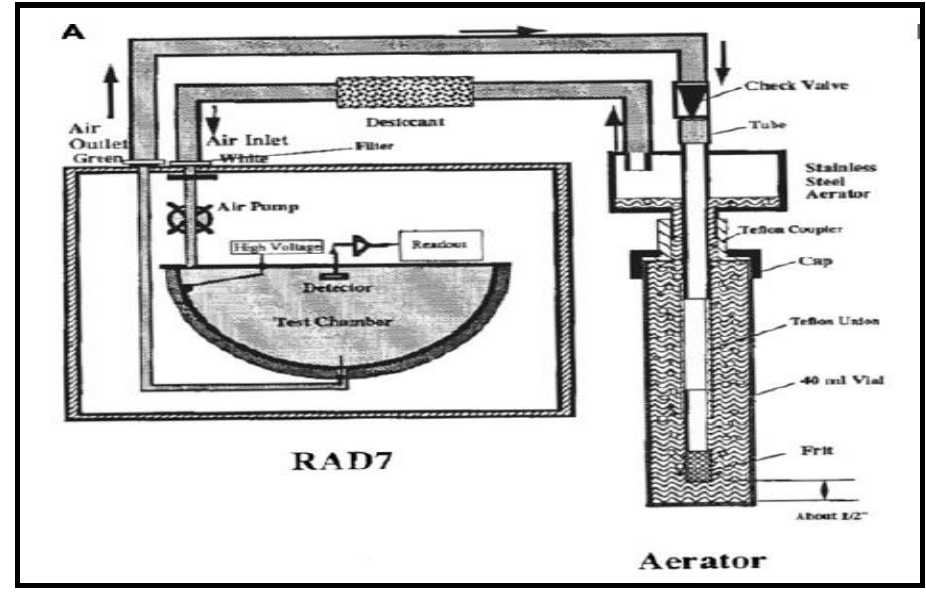
Fig.1: Schematic representation of the RAD 7 instrument for measuring radon in water